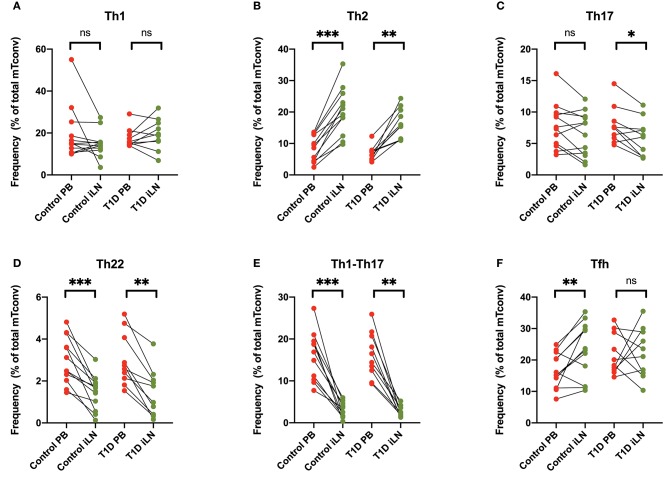
Differences in chemokine receptor expression on memory CD4+ T cells between blood and iLN. (A–F) Paired frequencies of CD4+ helper T cell populations in blood and iLN from control and T1D subjects. Frequencies of each cell type are expressed as a percentage of total memory CD4+ conventional T cells (i.e., FOXP3− CD4+ T cells). Student's t-test or Wilcoxon signed-rank test was used. *p < 0.05, **p < 0.01, ***p < 0.001, ns, not significant.